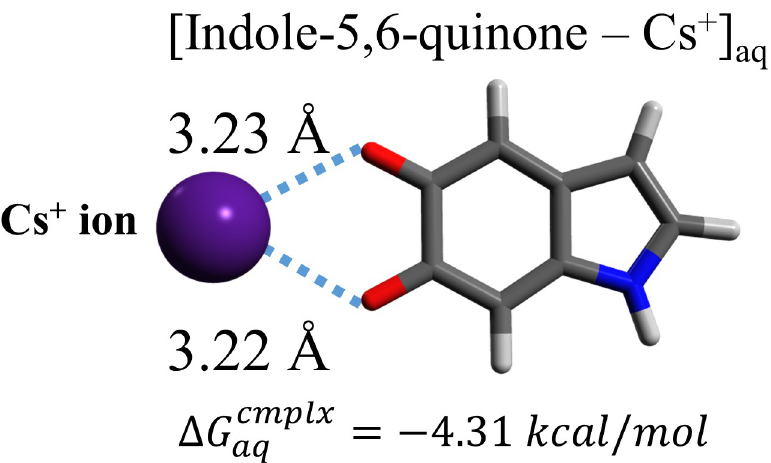
Fig 9. Most stable structure for the Cs + ion complex with indole from a melanin molecule in the aqueous phase. This typical functional compound of a melanin monomer, the indole group, was used for quantum chemical calculations. The distances from the Cs + ion to the nearest oxygen atoms of the molecules are indicated. Each symbol shows element bonds: grey, C; white, H; blue, N; red, O.